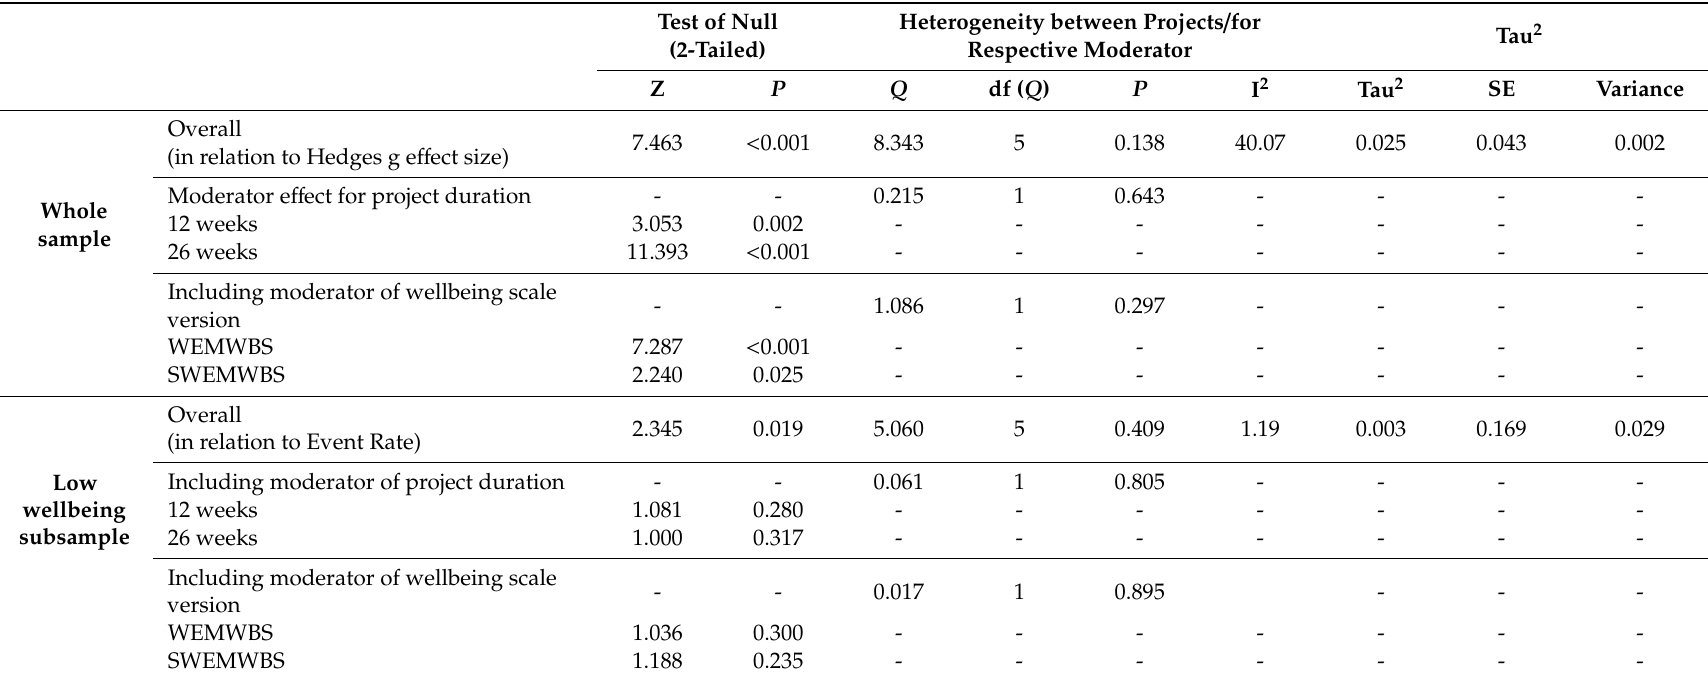
Table 2. Multi-study analyses statistical values for the whole